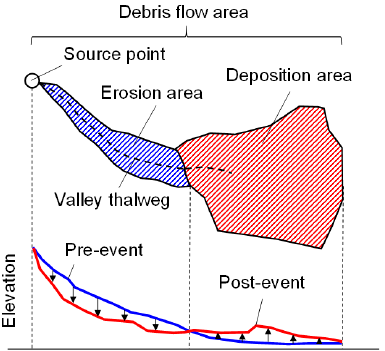
Figure 2. Schematic plan and cross-section of debris flow area.